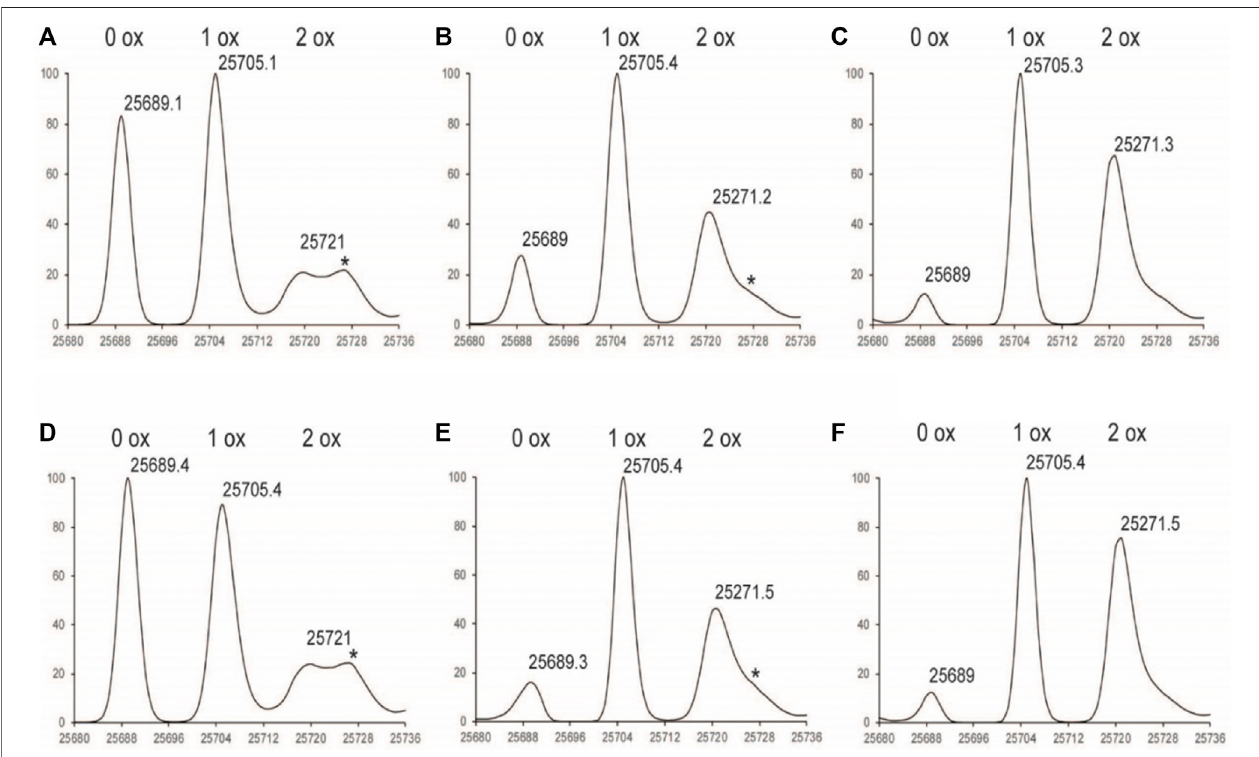
FIGURE 3 | Deconvoluted LC-MS Spectrum of Fd subunit (A) 1% Nox 1hr (B) 1% Nox 3hr (C) 1% Nox 6hr (D) 1% PAox 1hr (E) 1% PAox 3hr (F) 1% PAox 6hr *Denotes adduct peaks that do not correspond to actual oxidized antibody peaks.